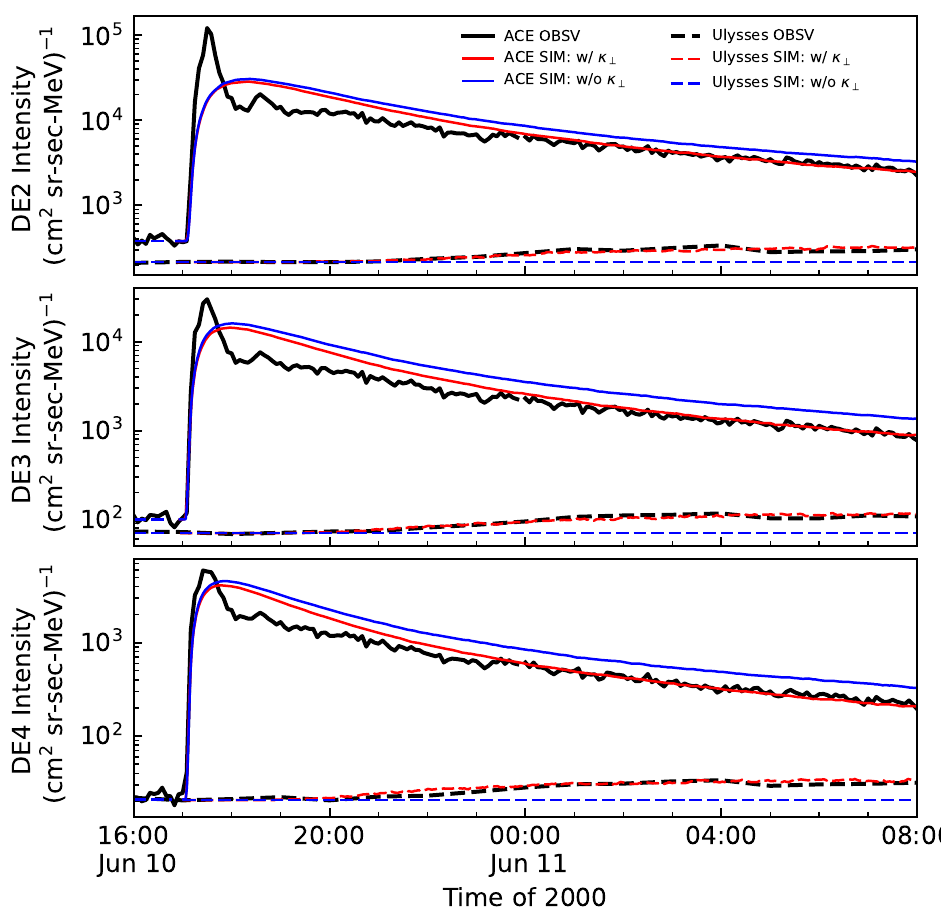
Figure 8. Similar as Figure 7 except the simulation results without perpendicular diffusion with blue lines are added in